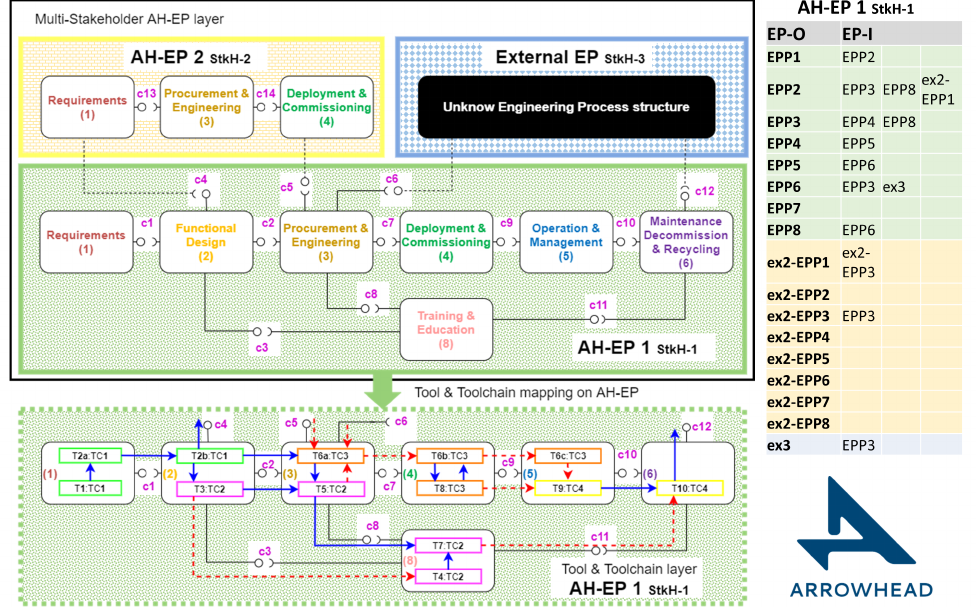
Figure 4. An example of a directed graph and tabular notations of two Arrowhead-EPs (AH-EP) from different stakeholders connected with an unknown EP from a third stakeholder. In the bottom part, we provide a more detailed view of the tools and tool-chain layer associated with Arrowhead-EP 1 of